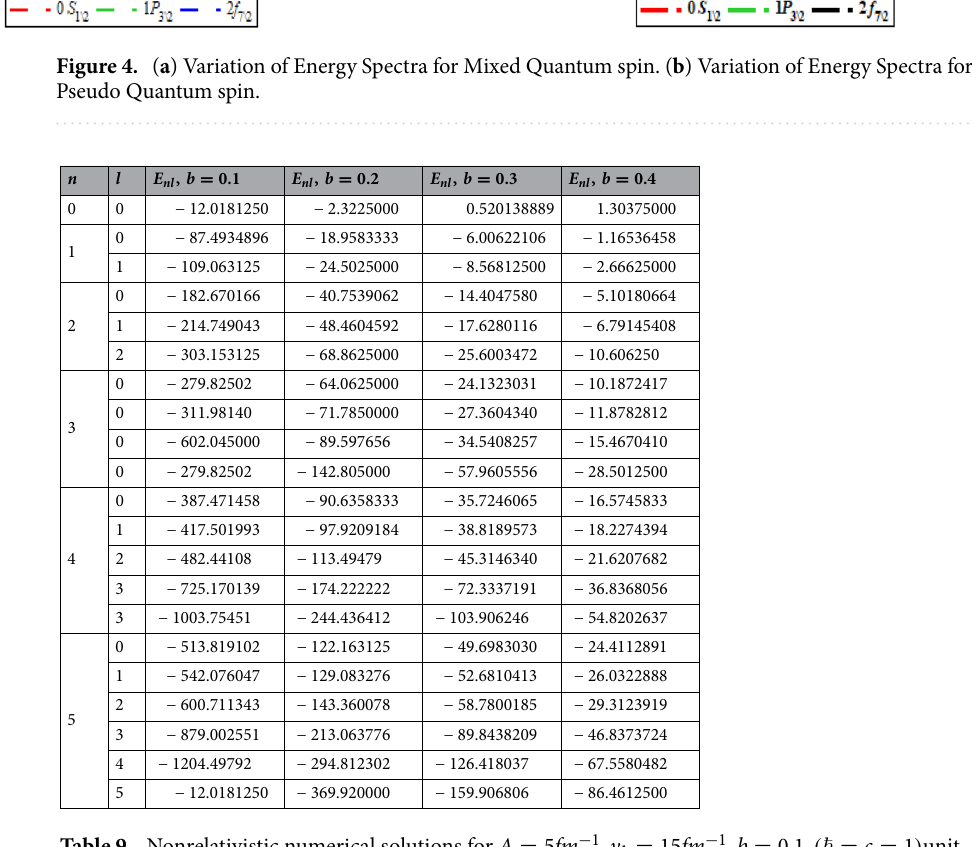
Table 9. Nonrelativistic numerical solutions for A